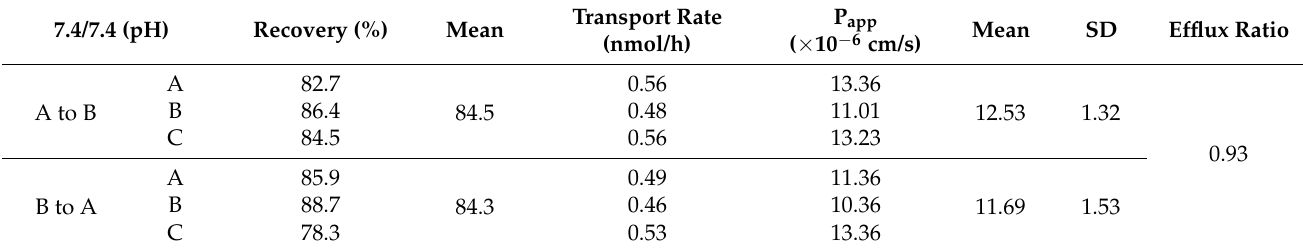
Table 3. Permeability and efflux ratio of tegoprazan from the Caco-2 permeability assay.